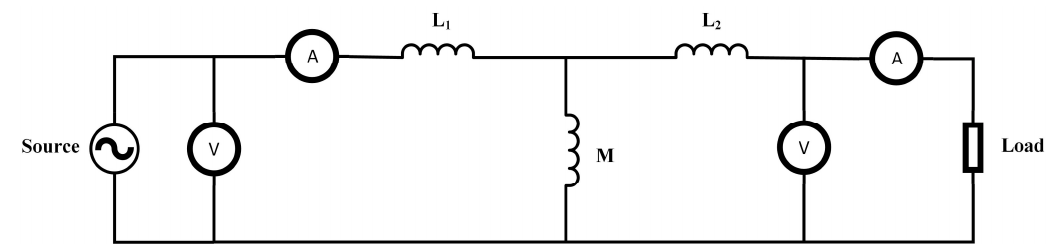
Figure 8. Electric circuit, pure resistive load, used in simulations.